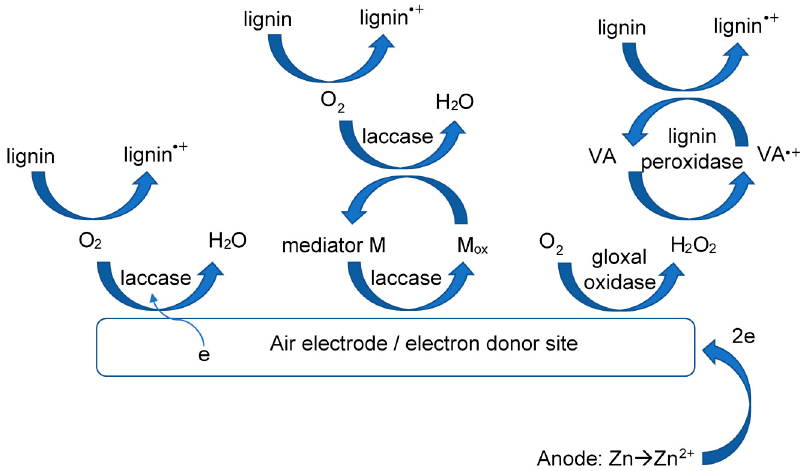
Figure 5. The illustration indicates the probable interactions between the air electrode as a charge donor site and several established reactions [34,35] involving extracellular enzymes during lignin oxidation.